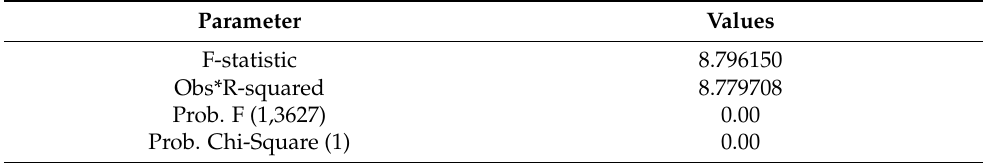
Table 6. Heteroskedasticity Test: